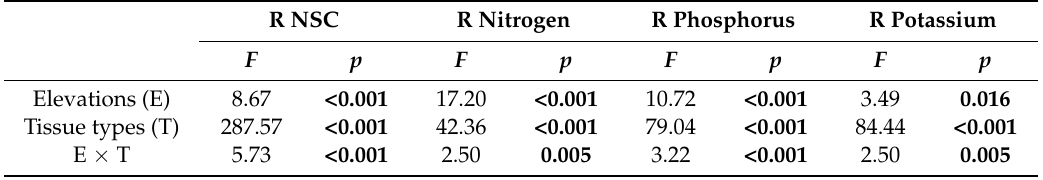
Table 3. Results of two-way nested ANOVAs with elevation and tissue types as fixed factors. The F and p values are given. R refers to remobilization rate.